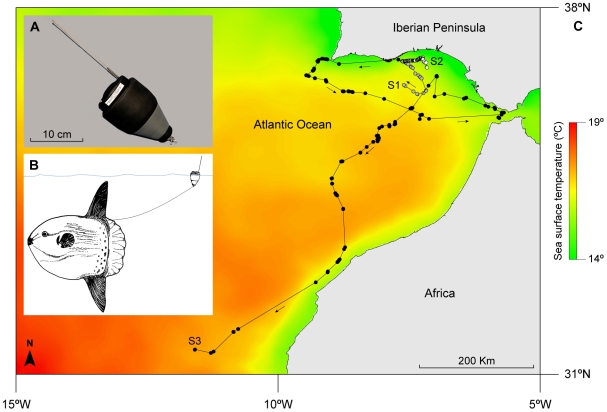
GPS tracks of ocean sunfish.(A) The fast-acquisition (Fastloc) GPS tag (depth rated to 1000 m) used to track sunfish in the north-east Atlantic (attachment method shown in B). (C) Three Tracks (S1–3) overlaid on a high resolution resolution (2 km) SST map averaged for the period between 6 November 2008 and 6 February 2009 (corresponding to track duration of S3).